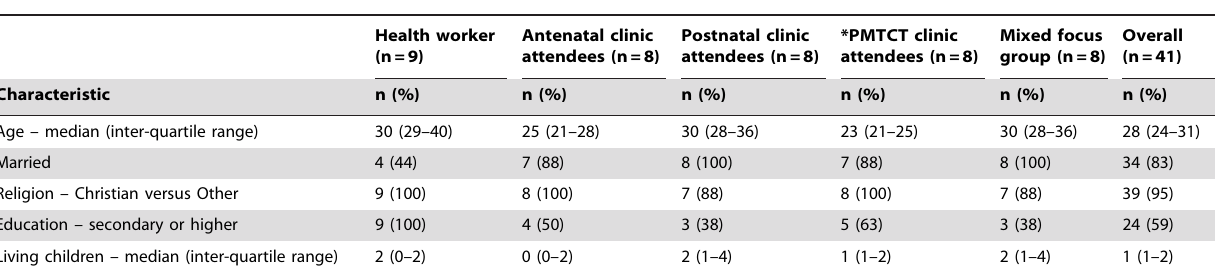
Table 2. Participant